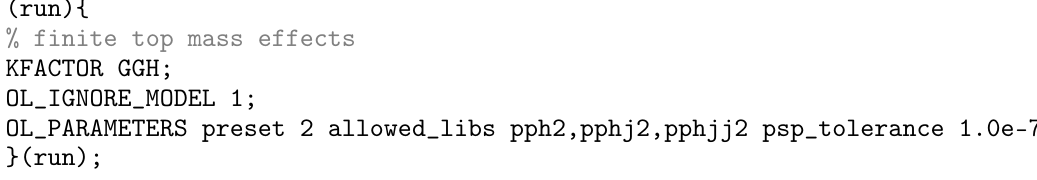
Figure 4: Predictions for the Higgs- boson transverse momentum distri- bution in gluon-fusion production at the L HC